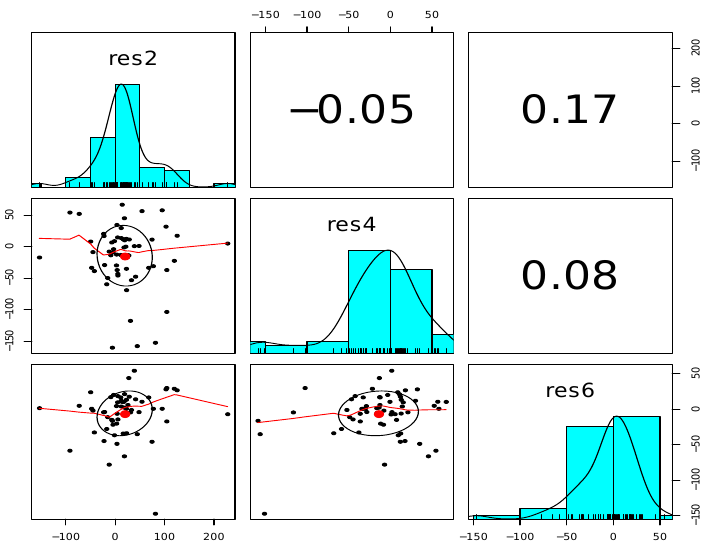
Figure 10. Histograms (diagonal), pairwise scatter plots ( bottom left ), and pairwise Kendall’s rank correlation coefficients ( top right ) of the prediction errors for stations 2, 4 and 6, which are CUT, UNV and